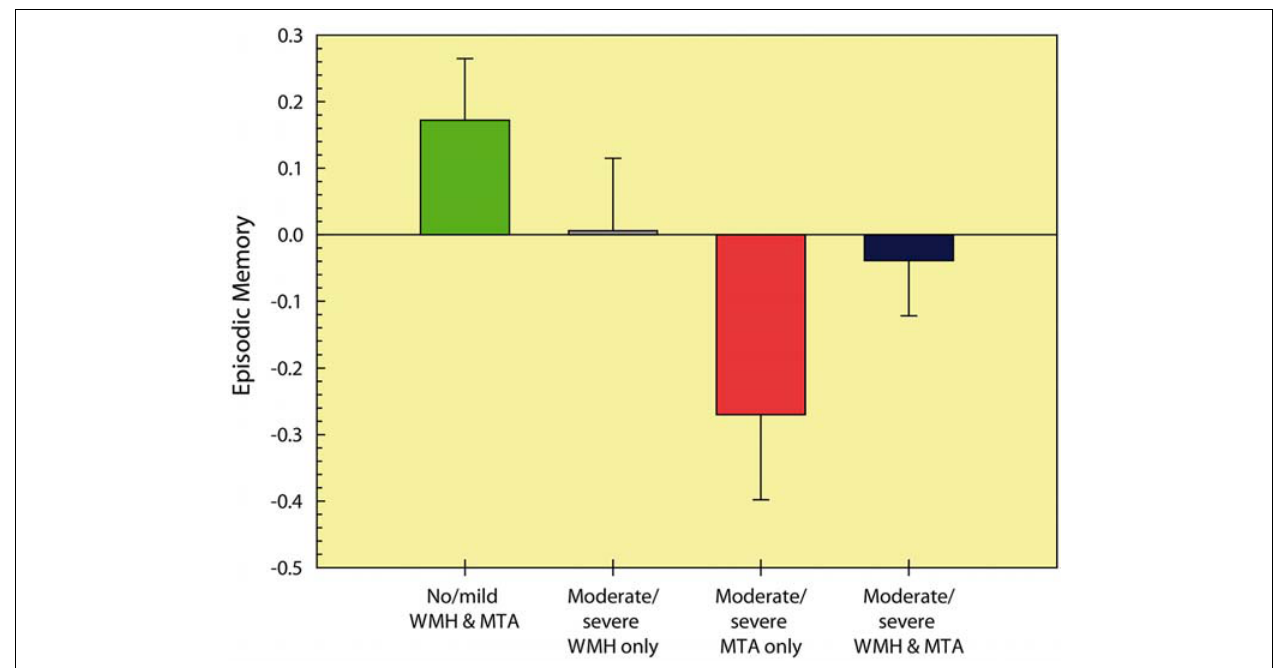
FIGURE 2 | Episodic memory performance of the different MTA andWMH severity groups. Higher cognitive scores represent better performance. MTA: medial temporal atrophy;WMH: white matter